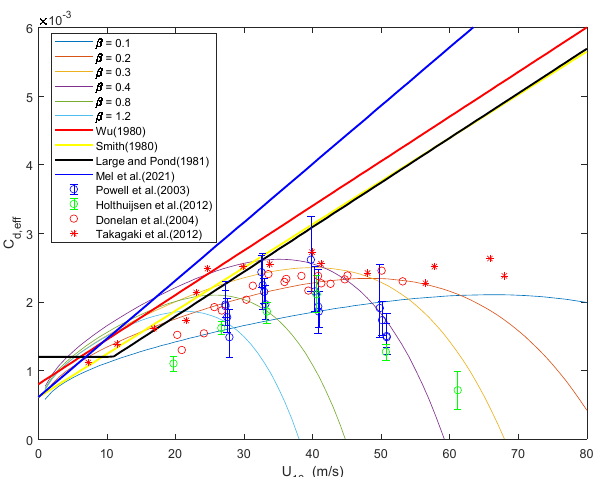
Figure 7. Variations of the effective sea surface drag coefficient with wind speed, considering the impact of sea spray droplets.